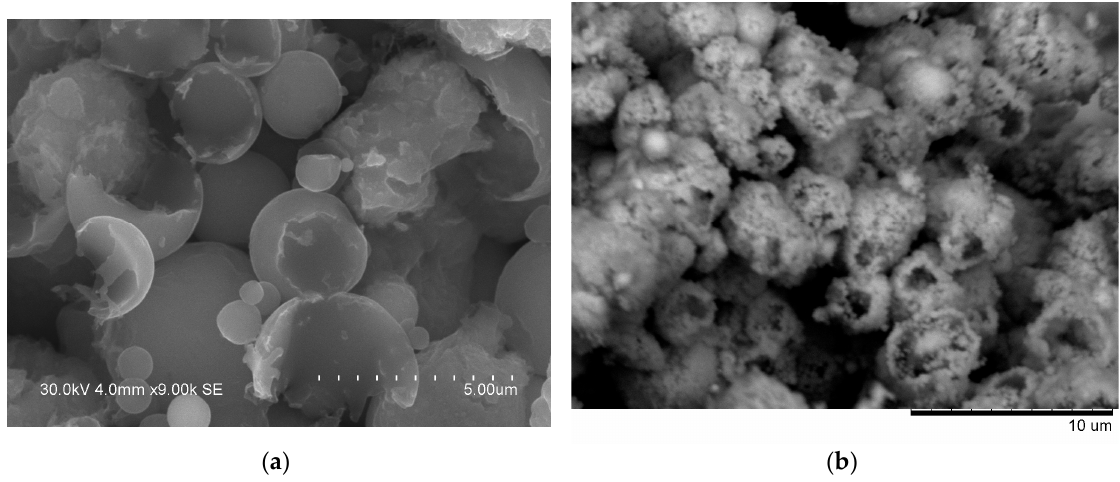
Figure 6. Morphology of the Al shells observed in the compacts formed by Fe-40at.%Al mixtures at an early stage of chemical interaction ( a ) and microstructure of these compacts after treatment in 20% NaOH solution ( b ); ( a ) SE image; ( b ) BSE image.